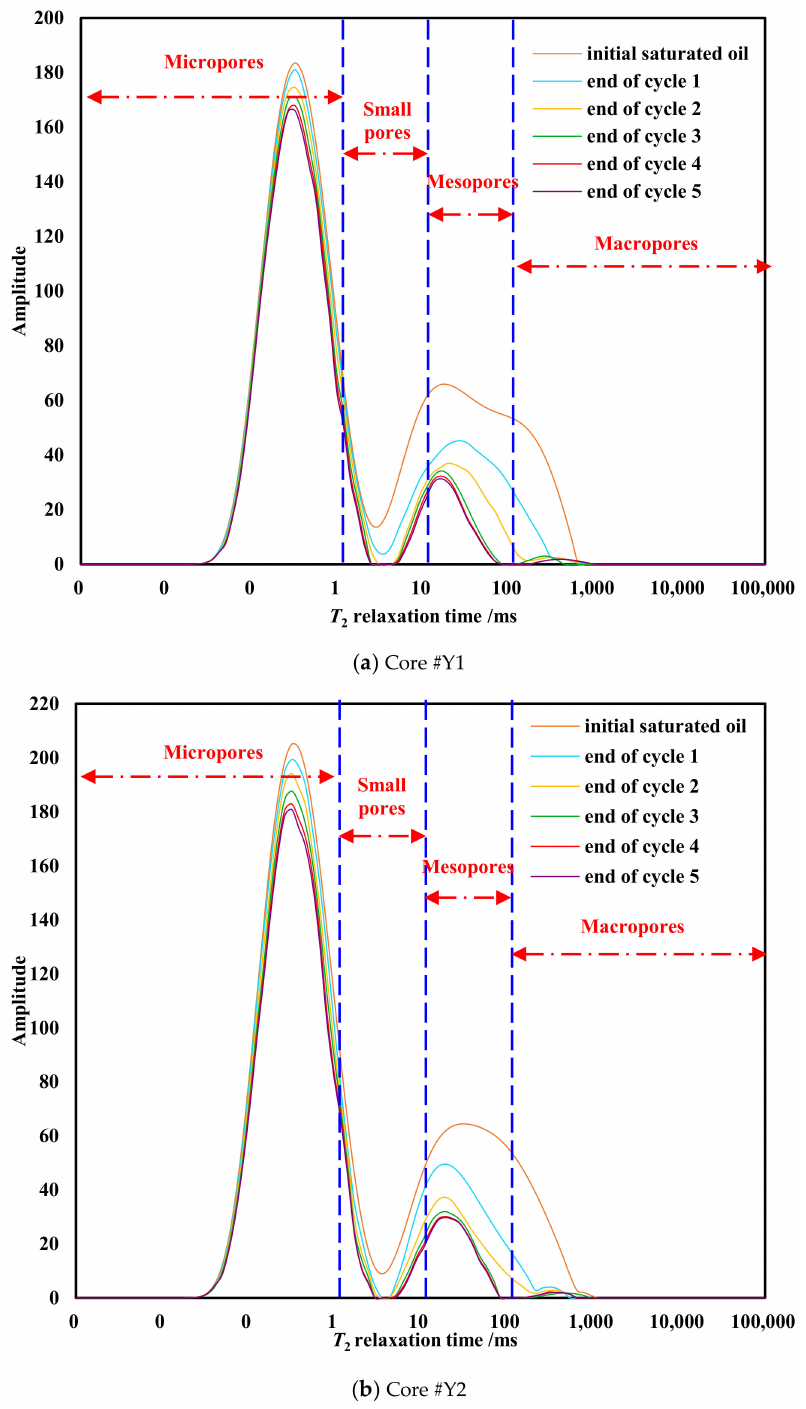
Figure 11. NMR T 2 spectrum curve after different cycles under 15